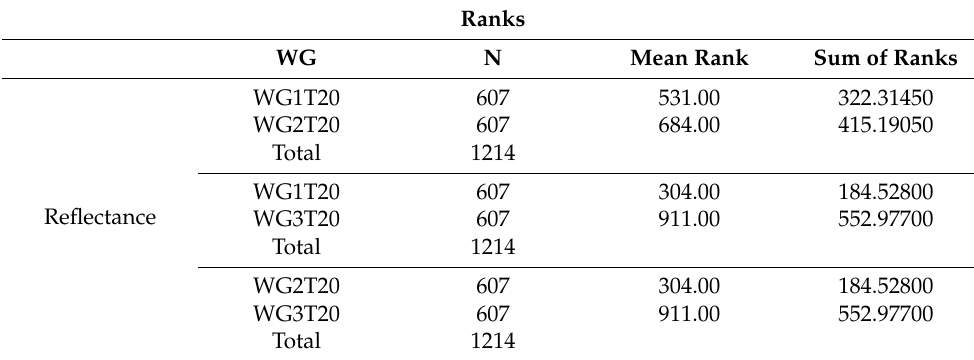
Table A9. Ranks table of the Mann–Whitney U test for specular solar reflectance, according to the holding time of 20 min.